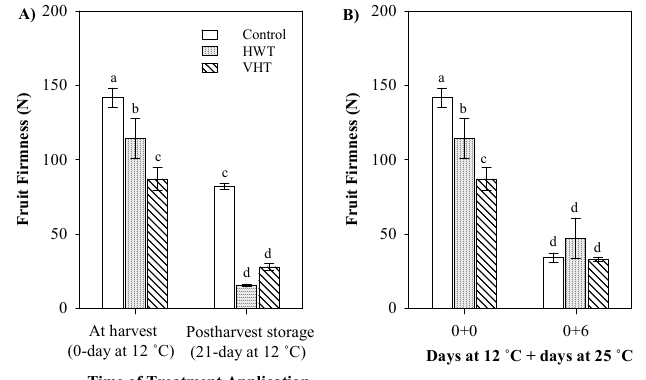
Figure 3. Effect of the heat treatments applied at harvest and post-harvest storage on the fruit firmness ( A , B ) of mango fruits. Error bars show standard errors of the means ( n = 3). Different letters indicate significant difference according to LSD at p ≤ 0.05.